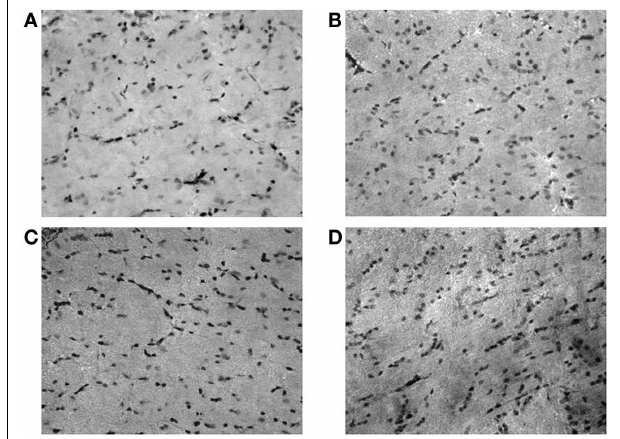
FIGURE 2 | Microphotographs of neuropeptideY (NPY)-positive neurons in rat hippocampus (dentate gyrus); (A) controls; (B)ACD rats atT1; (C)ACD rats atT16; and (D)ACD rats atT72 .The specific labeling is observed under bright-field illumination using a 100 × objective.